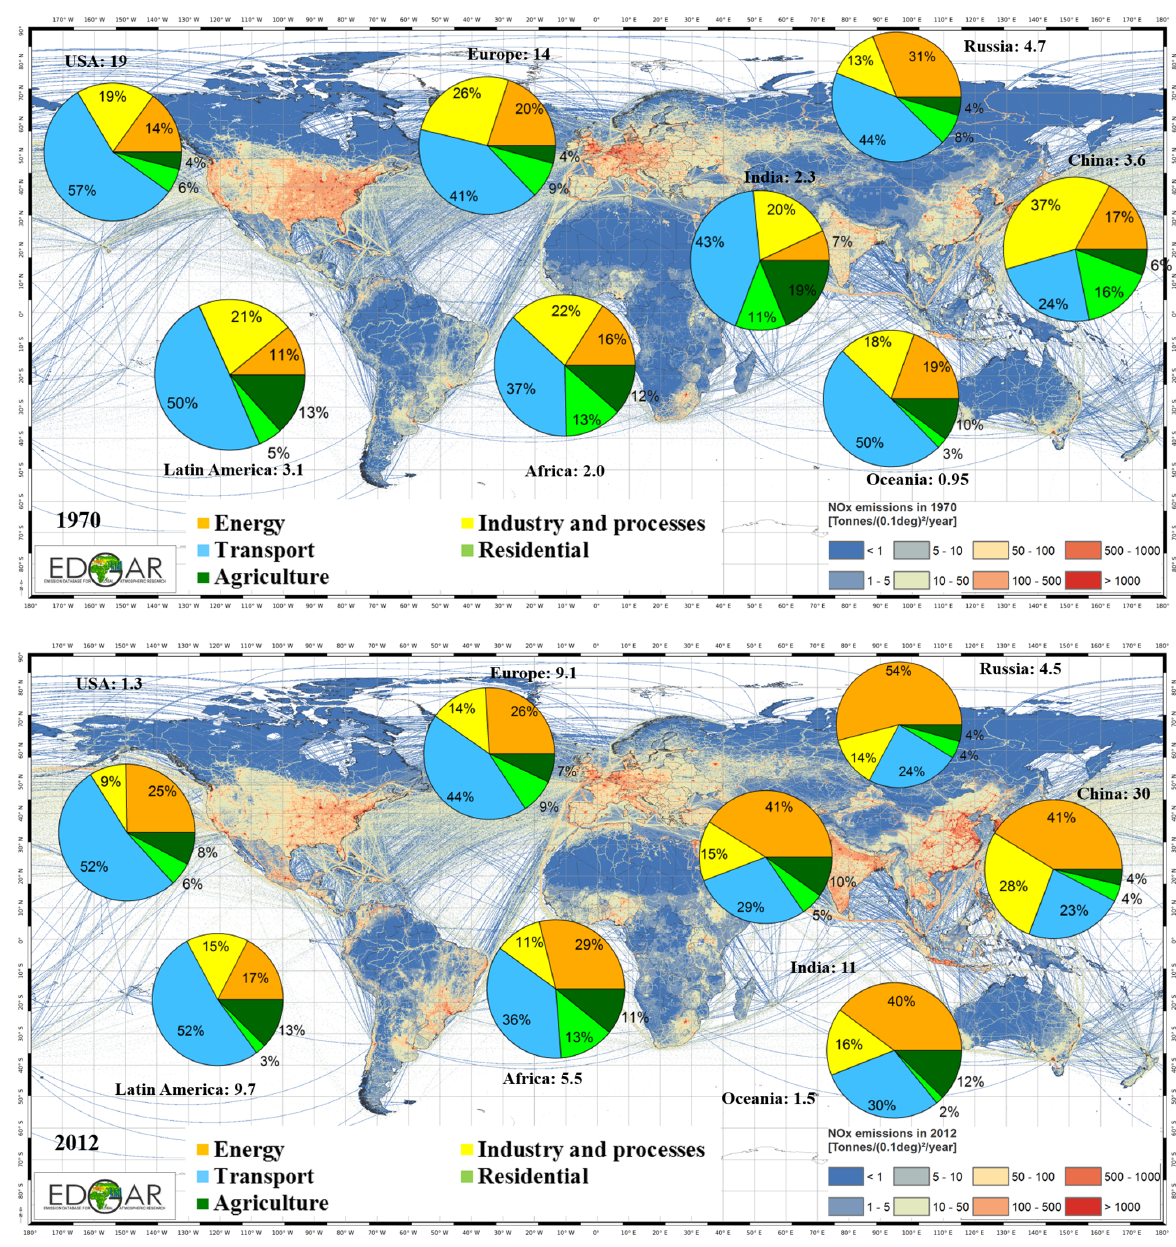
Figure 3. NO x emission grid maps and relative contribution of aggregated EDGAR sectors (energy, industry and processes, transport, residential, and agriculture) in world regions (pie charts) for 1970 and 2012. Total emissions (in Mtyr − 1 ) by region are also reported next to each pie